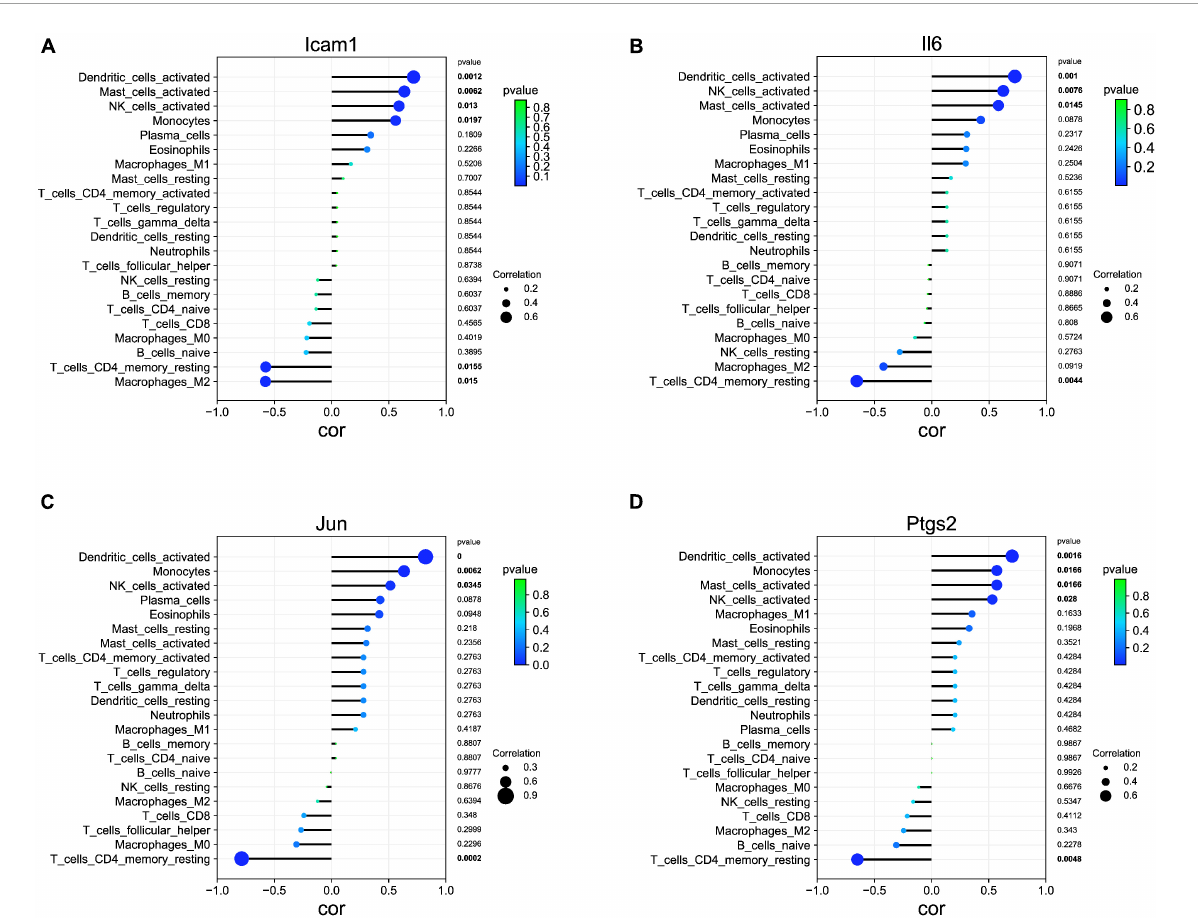
FIGURE7 Association of hub genes with immune infiltrates. (A) Correlation between Icam1 and infiltrating immune cells. (B) Correlation between Il6 and infiltrating immune cells. (C) Correlation between Jun and infiltrating immune cells. (D) Correlation between Ptgs2 and infiltrating immune